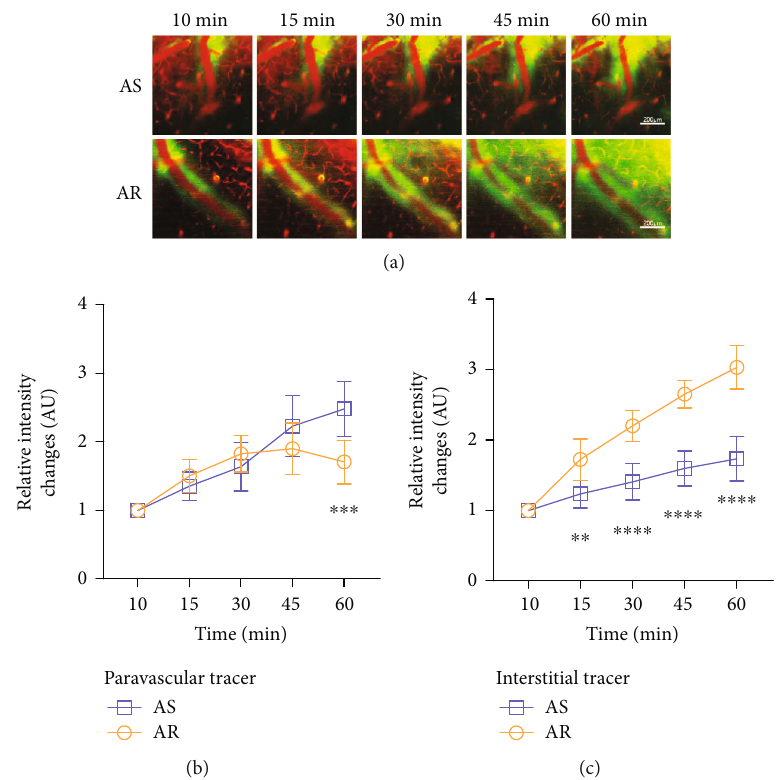
Figure 3: CTBS promotes glymphatic clearance in APP/PS1 mice. (a) In vivo two-photon imaging of tracer clearance through the glymphatic pathway in 10min, 15 min, 30min, 45 min, and 60 min in AS and AR groups (250 × , scale bar: 200 μ m). (b) Statistical quanti fi cation of CSF tracer in fl ux into the paravascular space. (c) Statistical quanti fi cation of CSF tracer penetration into the surrounding parenchyma. Data are presented as the mean ± SD ( n = 6 mice per group, two-way ANOVA with Tukey ’ s test for multiple comparisons; ∗ P < 0 : 05 , ∗∗ P < 0 : 01 , ∗∗∗ P < 0 : 001 , and ∗∗∗∗ P < 0 : 0001